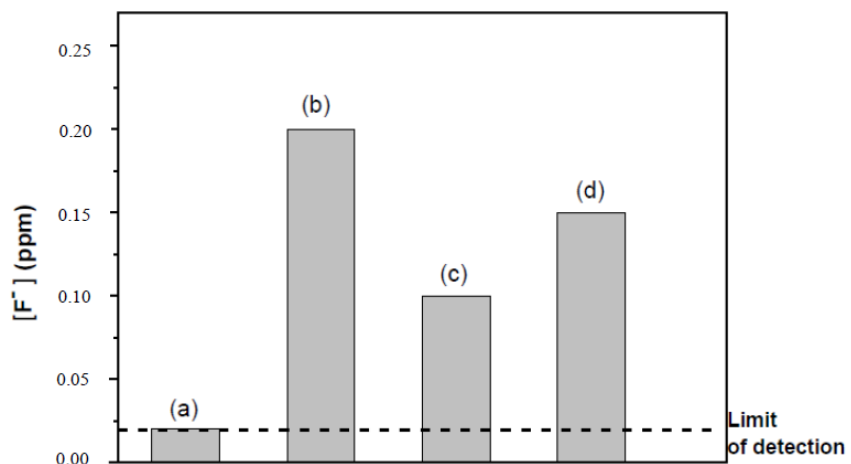
Figure 4. Histogram of the fluoride concentration released after 4 h in the Fenton reaction for the Aquivion ® membrane (without added Fe) (a) and composite membranes comprising untreated HNT (0.34 wt% Fe) (b) and acid-treated HNTs (0.23 wt% Fe) (c) and Aquivion ® membrane (with 0.23% of Fe added as (NH 4 ) 2 Fe(SO 4 ) 2 (H 2 O) 6 ) (d).